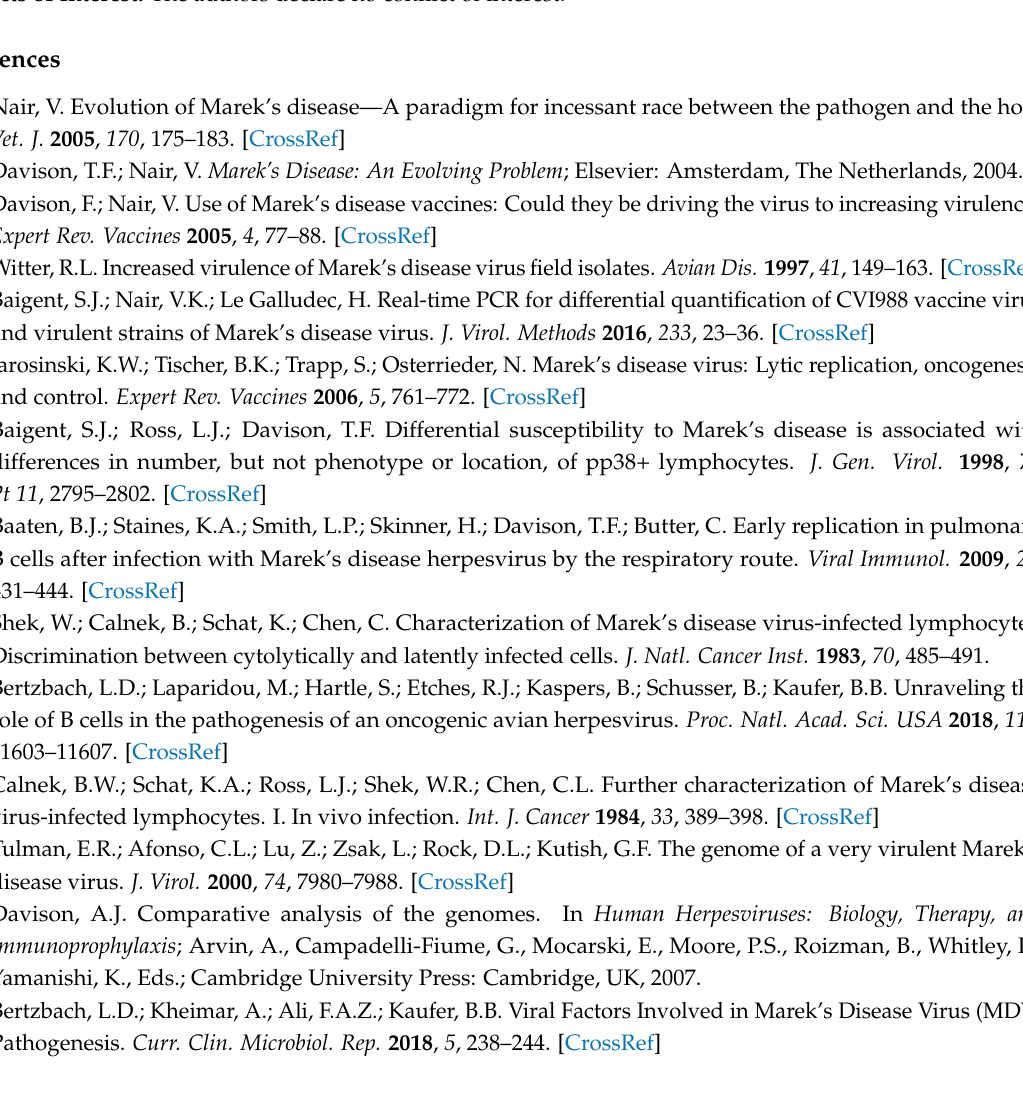
Supplementary Materials: The following are available online at http://www.mdpi.com/1999-4915/11/3/264/s1: Method S1: Generation and in vitro characterization of RB1B ∆ MetICP0, Figure S1: Protein concentration (mol%) scatterplot comparing levels of detected viral proteins in RB1B and CVI988 infected primary chicken B cells, Figure S2: Detected splice variants of UL15, Figure S3: RT-PCR confirmation of splicing events in pp38, Figure S4: Plaques size assay and western blot analysis for the ICP0 mutant RB1B ∆ MetICP0, Figure S5: Transmembrane helix prediction for spliced and unspliced pp24 and pp38, Figure S6: Prediction of serine, threonine or tyrosine phosphorylation sites in the hypothetical MDV protein SORF6 encoded on the U S segment, Table S1: Marek’s disease virus (MDV) proteins detected by mass spectrometry, Table S2: Primers used in this study, Table S3: Summary of RNA-seq read mapping, Table S4: Introns identified from RNA-seq data, Table S5: Poly(A) cleavage sites, polyadenylation signals and polycistronic transcripts identified in MDV transcriptomes, Supplementary File S1: Annotations for NC_002229.3 in GFF